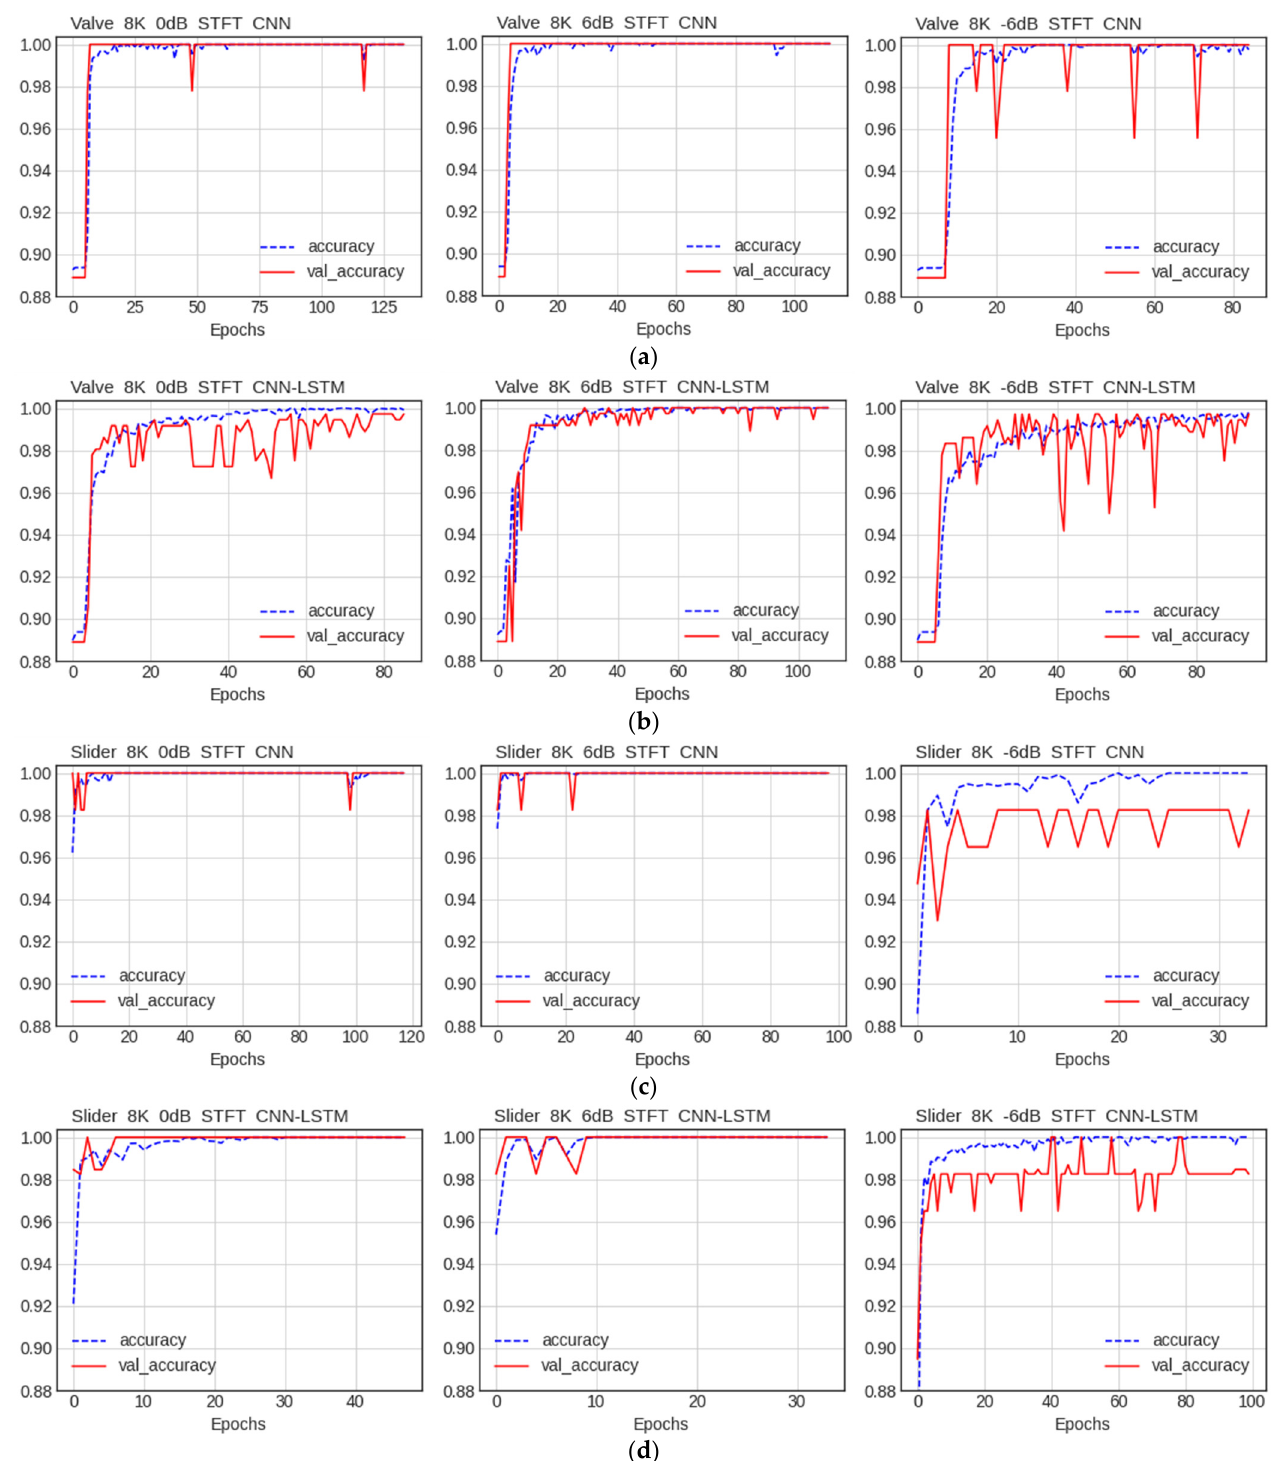
Figure 20. Accuracy of using data after preprocessing with the STFT transform (8 K, SNR: 0 dB, 6 dB, − 6 dB): ( a ) results of valve data training on the CNN model; ( b ) results of valve data training on the CNN–LSTM model; ( c ) results of slider data training on the CNN model; and ( d ) results of slider data training on the CNN–LSTM model.